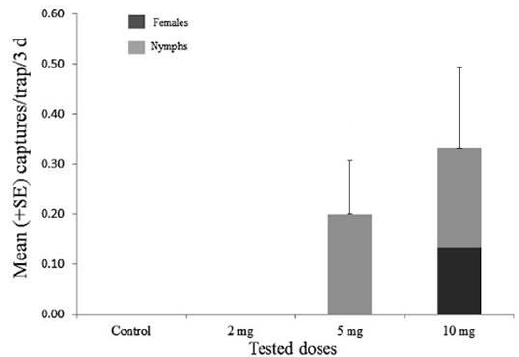
Figure 3. Emission rate of ( E )-2-octenyl acetate from polyethylene tube dispensers loaded with doses of 2, 5, and 10 mg. Different letters within the same day of sampling indicate statistical differences between doses at p < 0.01 (ANOVA, followed by Tukey’s test).